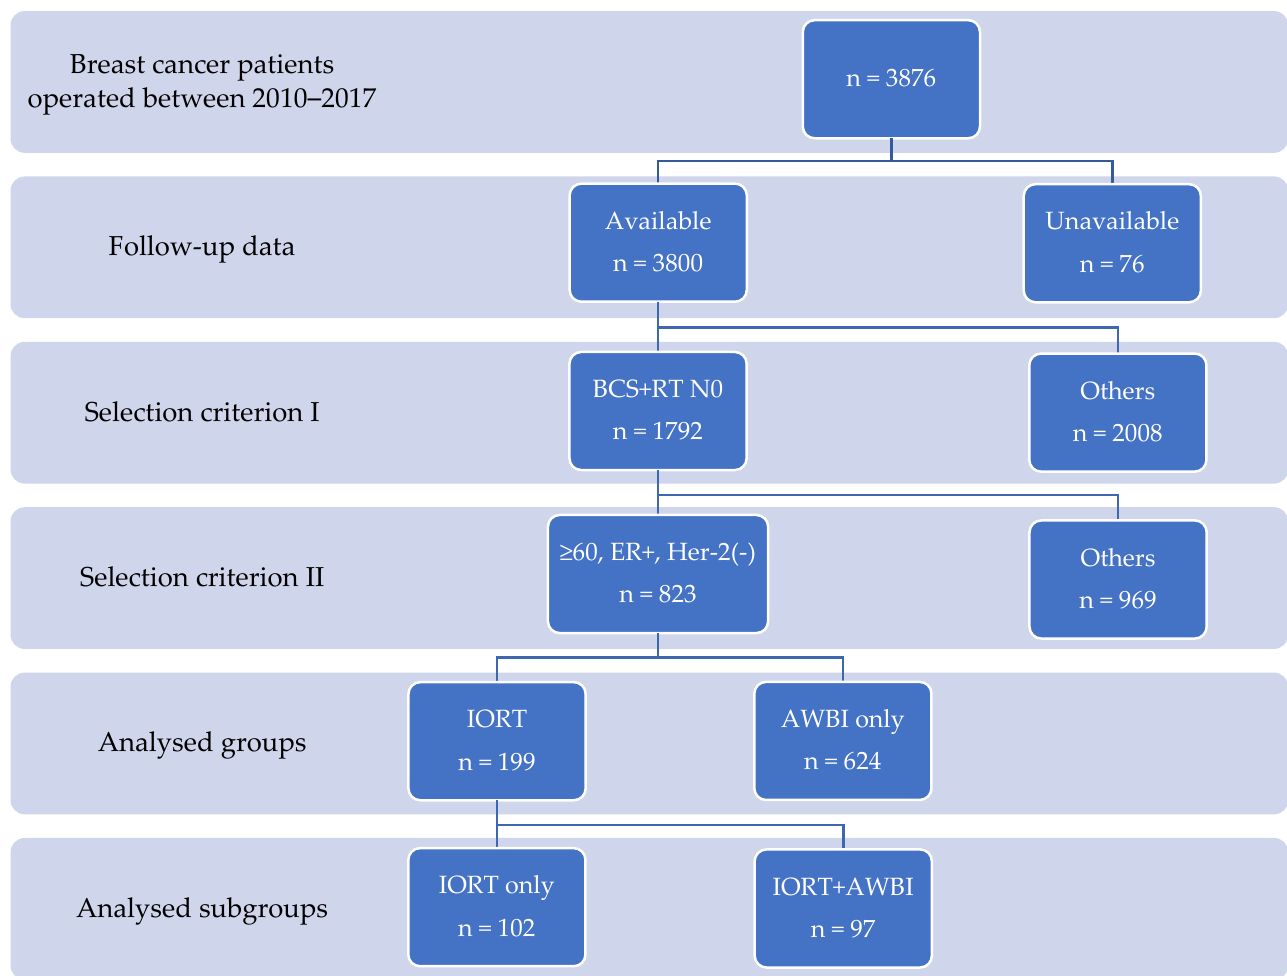
Figure 1. Patient selection criteria. BCS + RT N0: breast-conserving surgery with radiotherapy